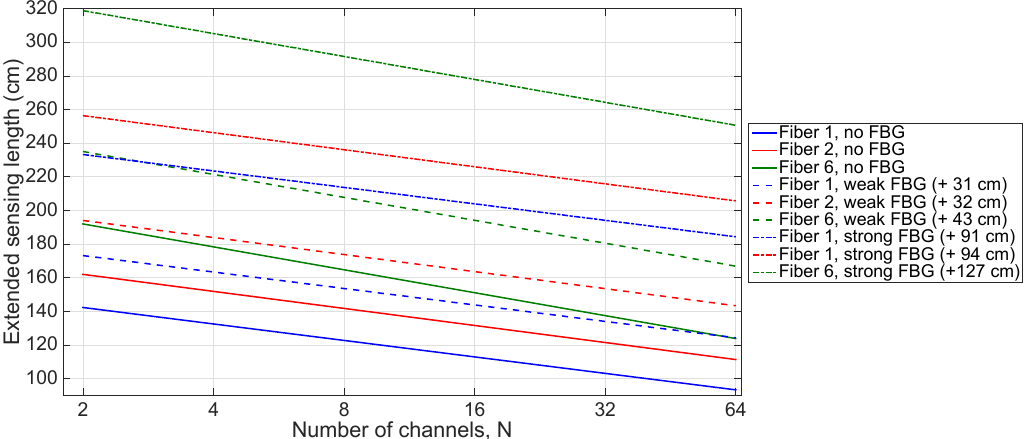
Figure 10. Extended sensing length ( S extended ) for M01 fibers 1, 2 and 6 in typical working conditions. The chart compares the SLMux performance in typical conditions, and when FBGs (weak, +9.5 dB; strong, +28.0 dB) are added to the span of sensing fiber.